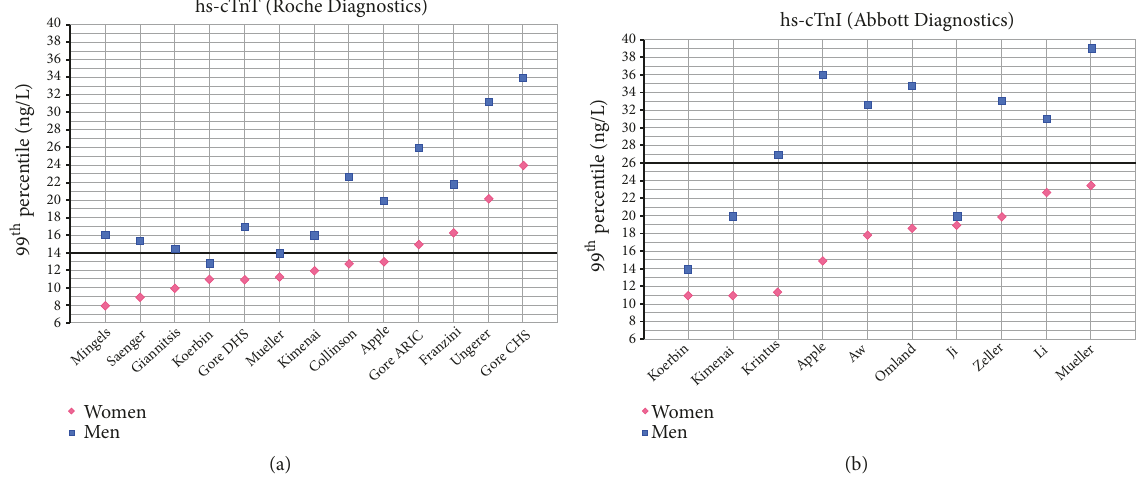
Figure 2: Chart showing different 99 th percentile values for hs-cTnT (panel a) and hs-cTnI (panel b) assays, derived from selected population studies as reported in Tables 1 and 2. Bold lines represent non-sex-specific, standard cut-offs for hs-cTnT and hs-cTnI (14 ng/L and 26 ng/L,